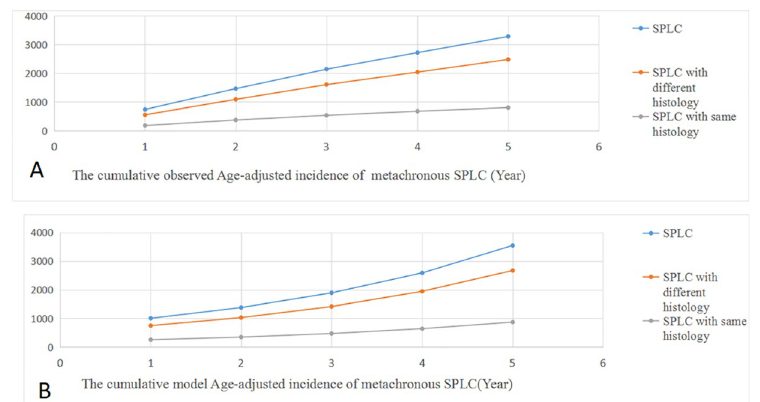
Fig 1. Incidence trends of metachronous second primary lung cancer(SPLC) (A).The cumulative observed age- adjusted incidence of metachronous second primary lung cancer (Year) (B).The cumulative model age-adjusted incidence of metachronous second primary lung cancer with competing risk (Year).